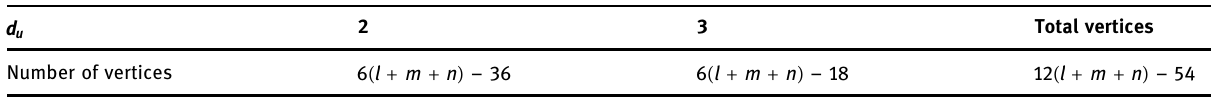
Table 2: Vertex partition of l m n ZCS , , ( ) d